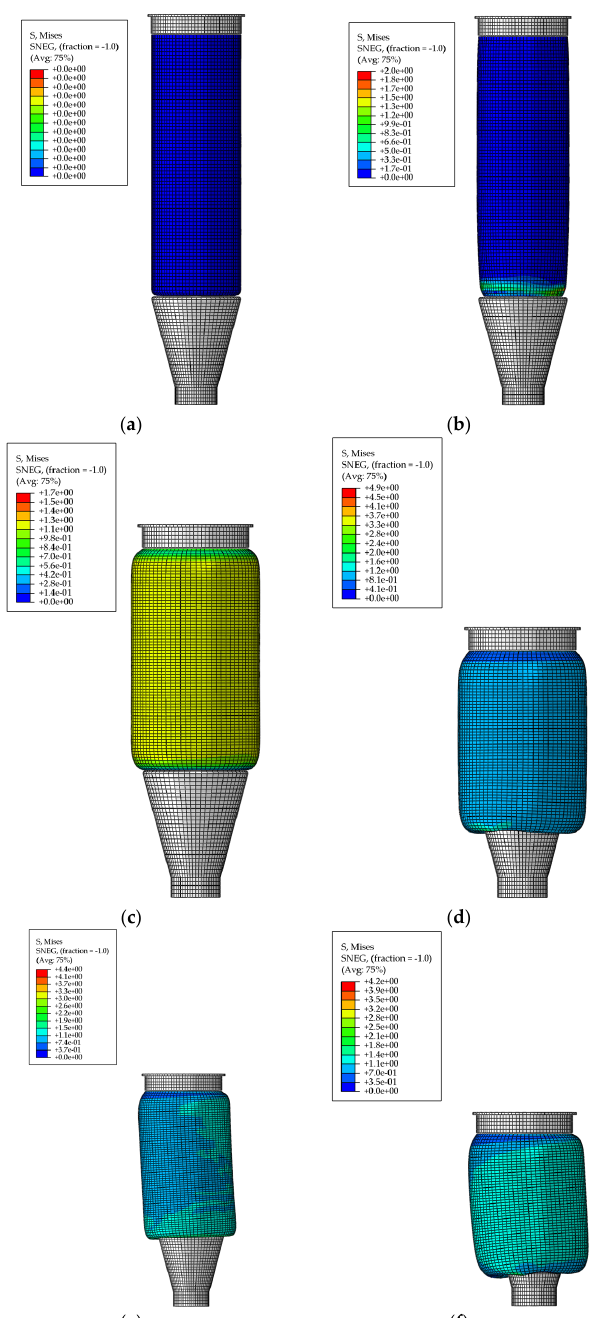
Figure 3. Load steps of the F E analysis: ( a ) unloaded, ( b ) first load step, ( c , d ) second load step, ( e ) third load step, ( f ) fourth load